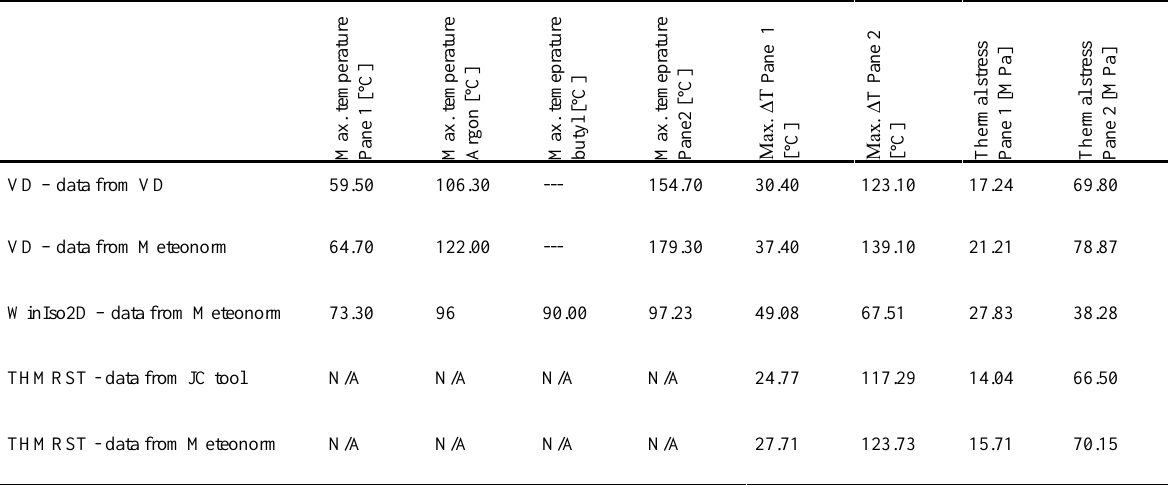
Table 7: Difference between a 1D and 2D analysis